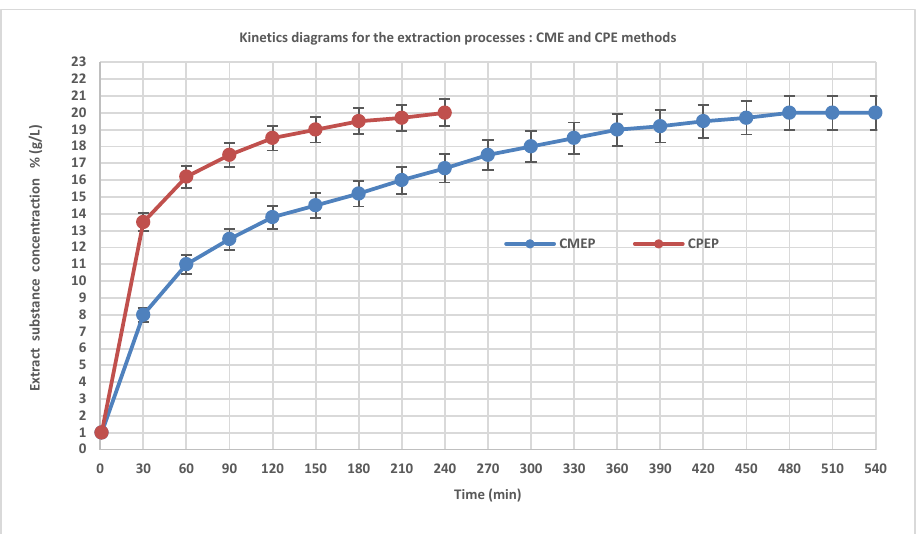
Figure 2. Kinetics diagrams for the extraction processes: conventional maceration extraction process (CME) and cyclically pressurized extraction process (CPE), with error bars.